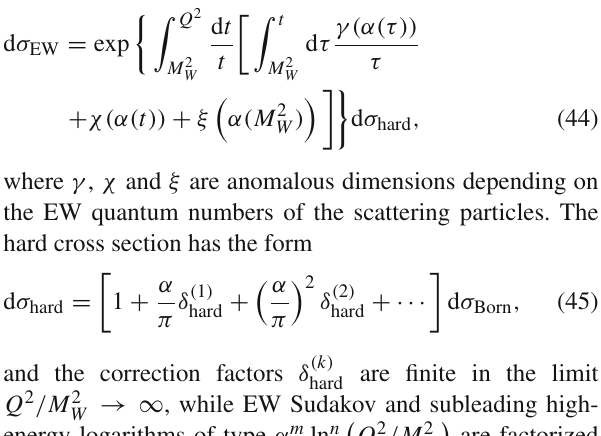
Fig. 8 Ratios of p T -distributions for various pp → V + jet processes atLO,NLOandNNLOQCD.TheNLOandNNLOQCDuncertainties, estimated according to Eqs. (33), (35), and (38) are correlated amongst